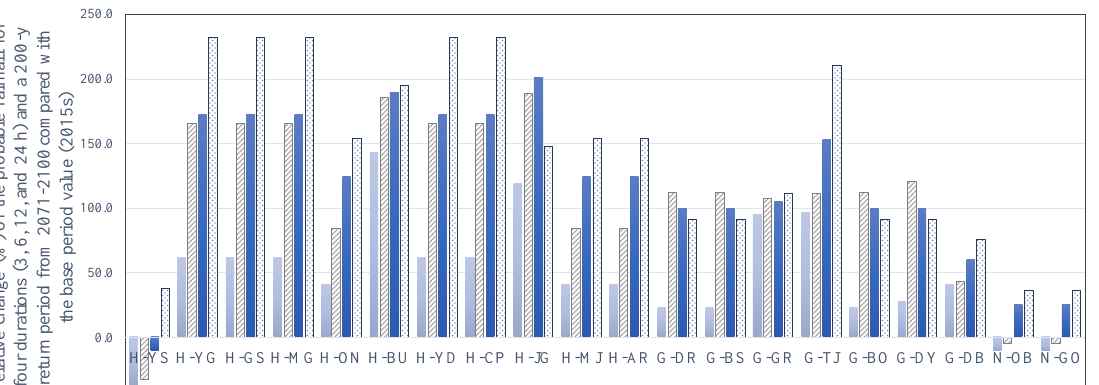
Figure 5. Relative change (%) of the probable rainfall for four durations (3, 6, 12, and 24-h) and a 200-y return period from 2071–2100 compared with the base period value (2015s) under the RCP4.5 scenario for 30 agricultural reservoir watersheds. Refer to Table 1 for reservoir names.